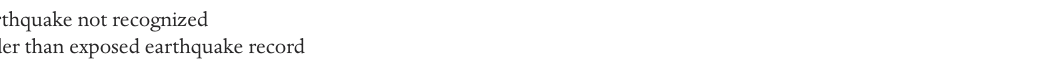
Table 4. Earthquake timing comparison with nearby paleoseismic studies on the NAF and correlated historical earthquakes (historical earthquake records are summarized in Table 1), summarized graphically in Figure 10. Note: '—' corresponds to 'earthquake not recognised' and 'X' corresponds to 'older than exposed in earthquake